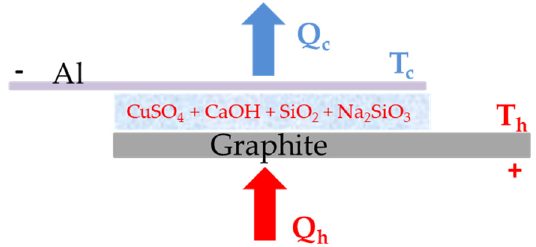
Figure 2. Seebeck coefficient of graphite/mixture/aluminum system as a function of temperature.